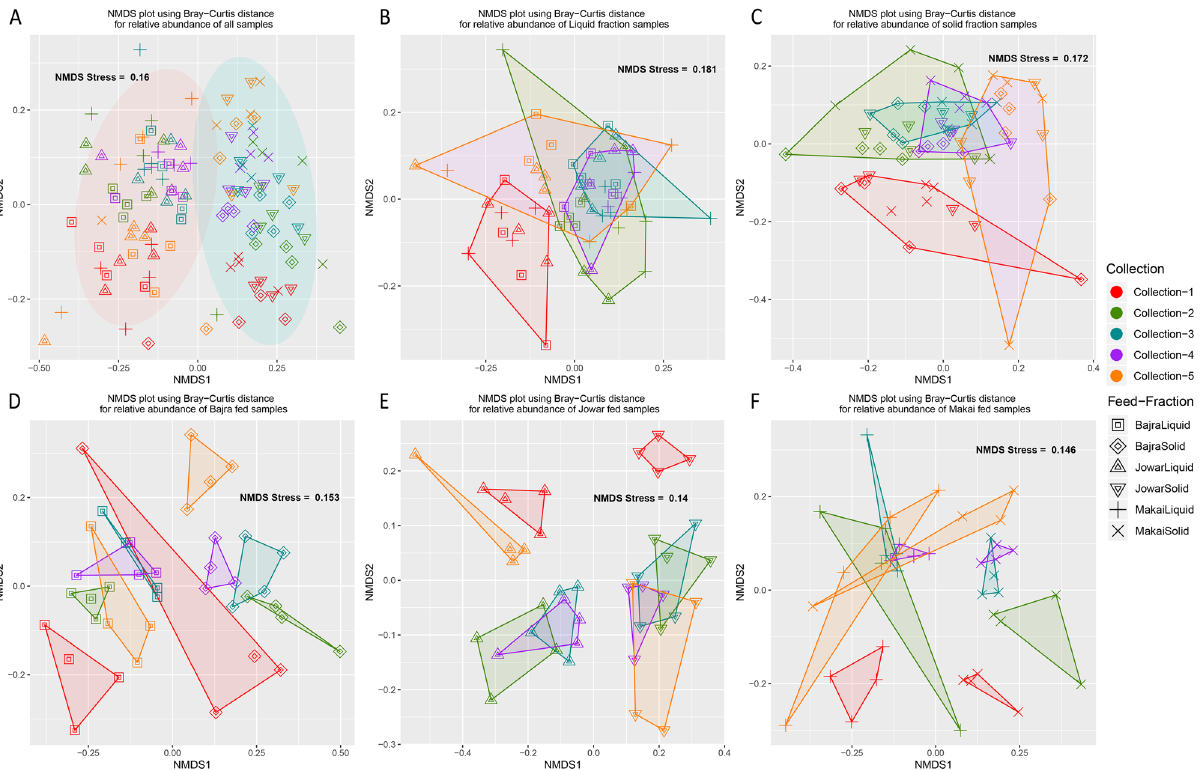
Figure 2. NMDS plots plotted from Bray–Curtis distances calculated from the relative abundances of ( A ) all samples, ( B ) samples from liquid fraction, ( C ) samples from solid fraction, ( D ) samples from Bajra fed animals, ( E ) Jowar fed animals and ( F ) Makai fed animals. All the plots are commonly colored by Collection and shaped by feed-fraction